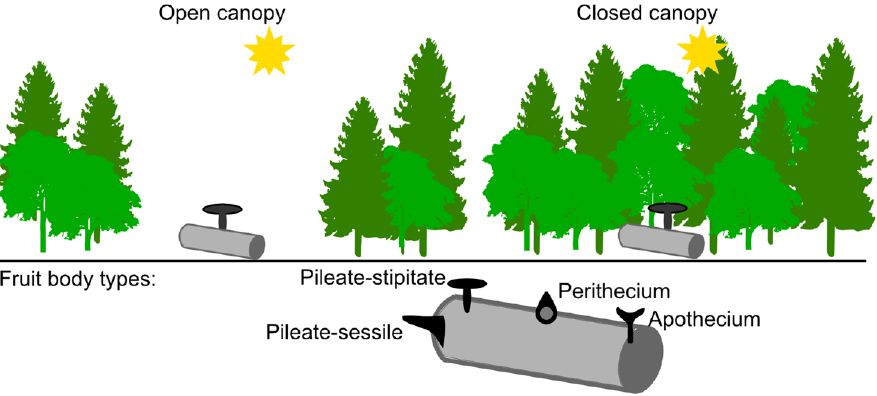
Figure 1. Conceptual representation of the study treatment and fruit body types. Random block design with five blocks, each with 12 plots with open and 12 with a closed canopy. Forest stands with open canopies are characterized by direct sun exposure and thus increased radiation, heat, and drought (“harsh microclimate”), compared with forest stands with closed canopies 7,11 . We investigated trait change of four fruit body types: pileate-stipitate and pileate-sessile for Basidiomycota and Perithecia and Apothecia for Ascomycota. Illustration by F.-S.